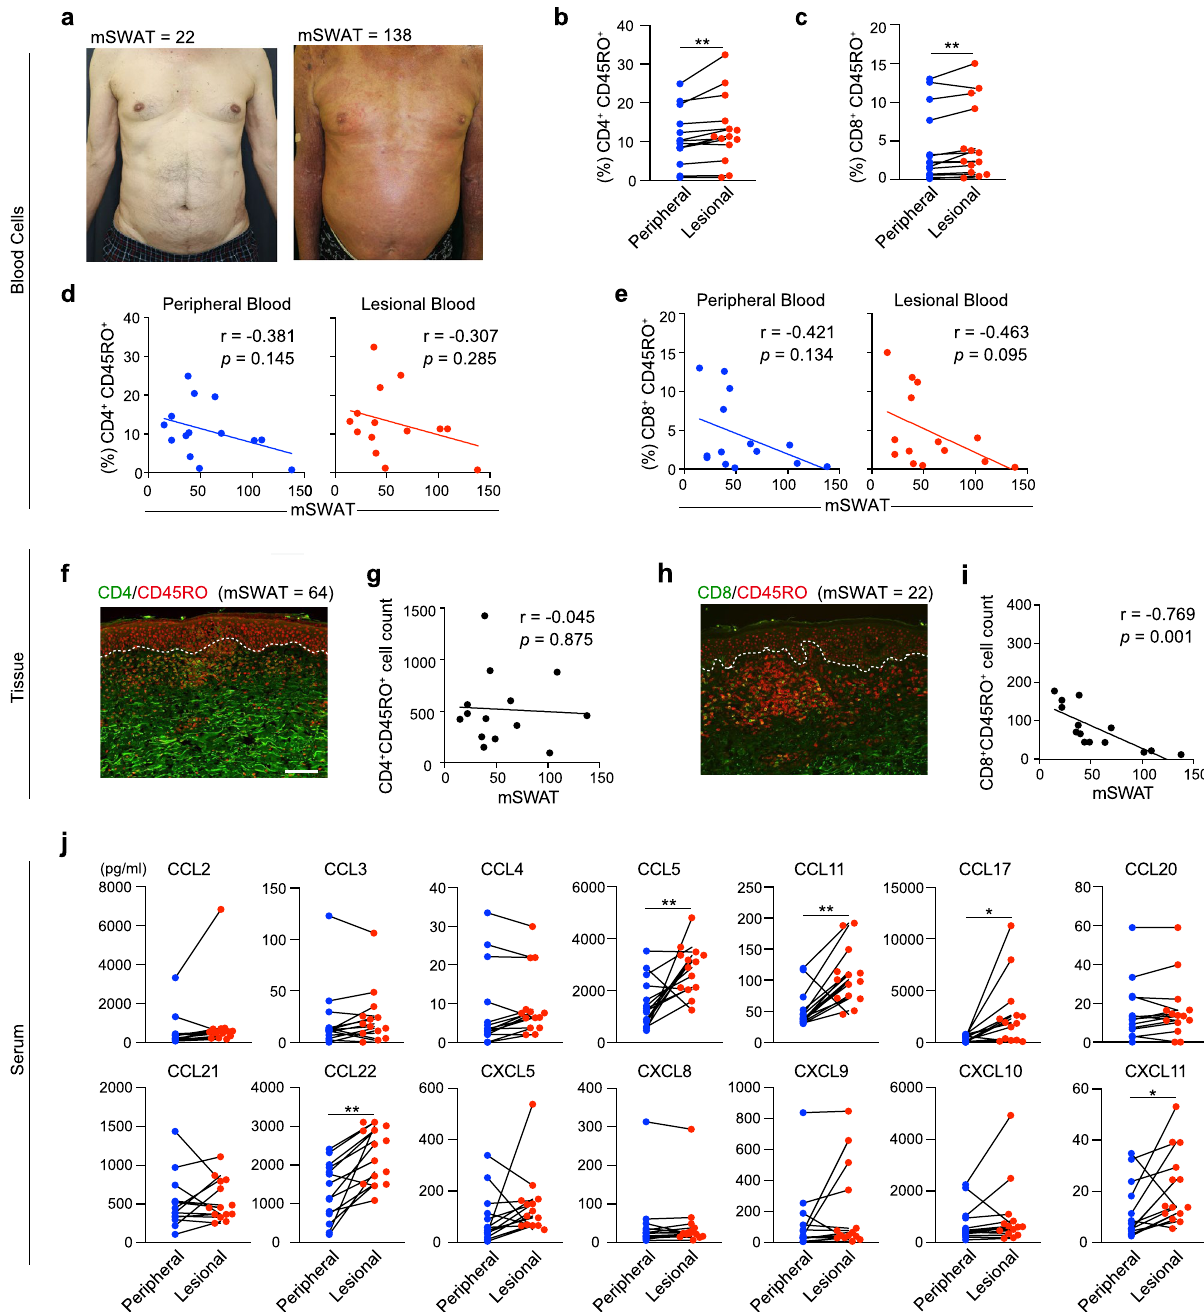
Figure 2. CD8 + CD45RO + cells negatively correlate with the mSWAT score in patients with MF. ( a ) Typical clinical features of MF lesional skin with an mSWAT score of 22 (left) and an mSWAT score of 138 (right). ( b,c ) The percentage of CD4 + CD45RO + and CD8 + CD45RO + T cells in lesional blood was higher than that in peripheral blood. Paired t -test. ** P < 0.01. ( d,e ) Correlation of CD4 + CD45RO + T cells and CD8 + CD45RO + T cells in peripheral blood and lesional blood with the mSWAT score evaluated by Pearson correlation coefficient analysis (n = 14). ( f–i ) Representative immunofluorescence staining of CD4/8 (green) and CD45RO (red) in MF lesional skin. Scale bar = 100 μm. Correlation of CD4 + CD45RO + cells and CD8 + CD45RO + cells with mSWAT (n = 14) evaluated by Pearson correlation coefficient analysis. Quantification of the number of cells per visual field was performed using the Hybrid Cell Count BZ-H4C analyzer software. Data were statistically analyzed using the Pearson correlation test (2-tailed). j ) Results of multiplex chemokine bead assay using sera from peripheral and lesional blood (n = 14). Paired t -test. * P < 0.05, ** P <